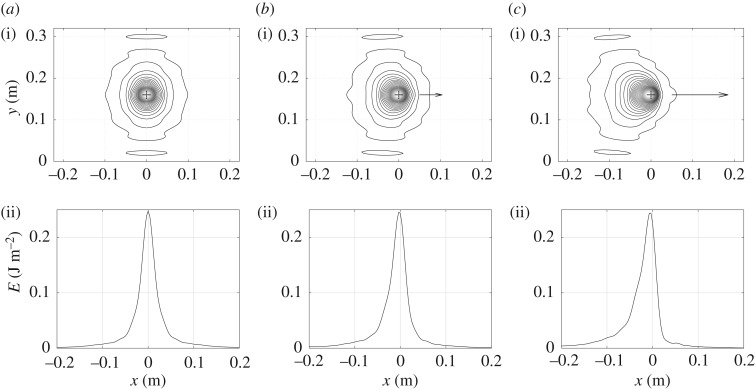
Repartition of Eulerian vibrational energy Ed near the moving point force at f = 2000 Hz for various moving speeds. Isovalues of energy (i) and energy versus position along the horizontal line y = 0.16 (ii). (a) V = 0 km h−1, (b) V = 90 km h−1 and (c) V = 216 km h−1.